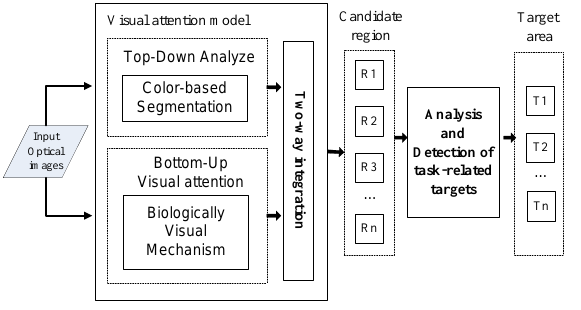
Fig.1. The detection flowchart of traffic sign